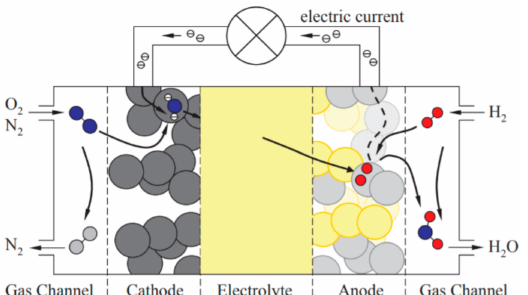
Figure 1. Schematization of the Solid Oxide Fuel Cells (SOFC) operating principle & constituent materials